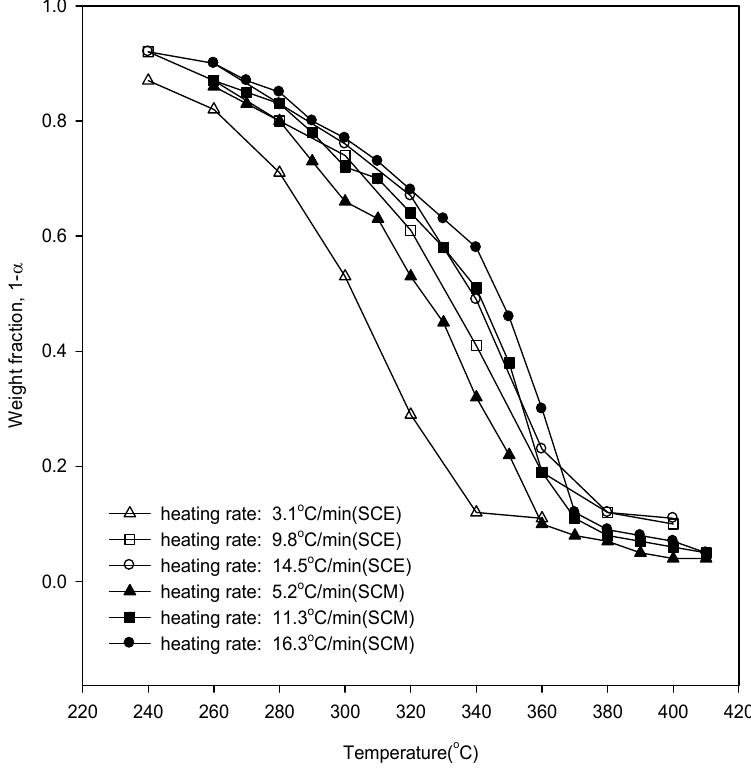
Figure 2. Weight loss data of wood degradation in SCE and SCM.